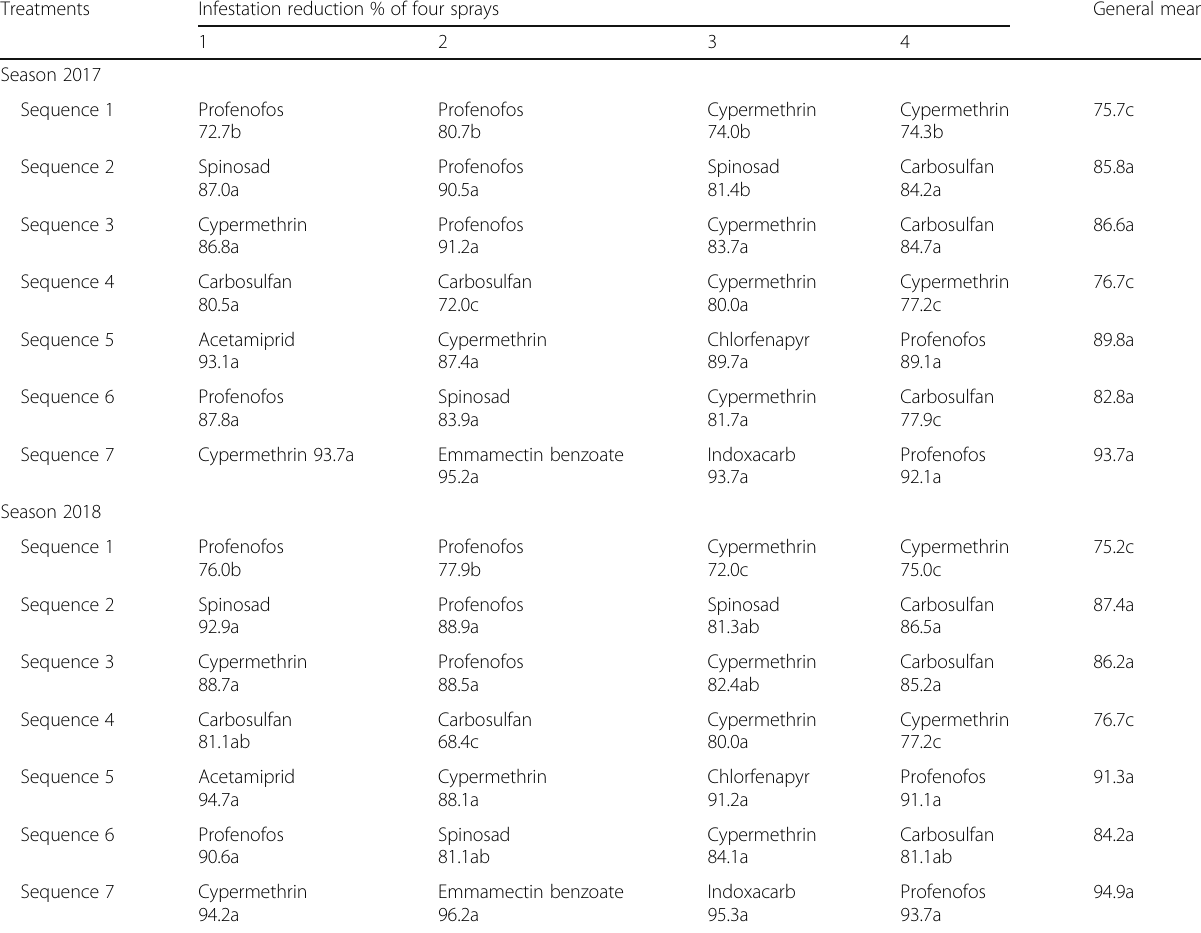
Table 4 Infestation reduction percentage of cotton bollworms during two seasons